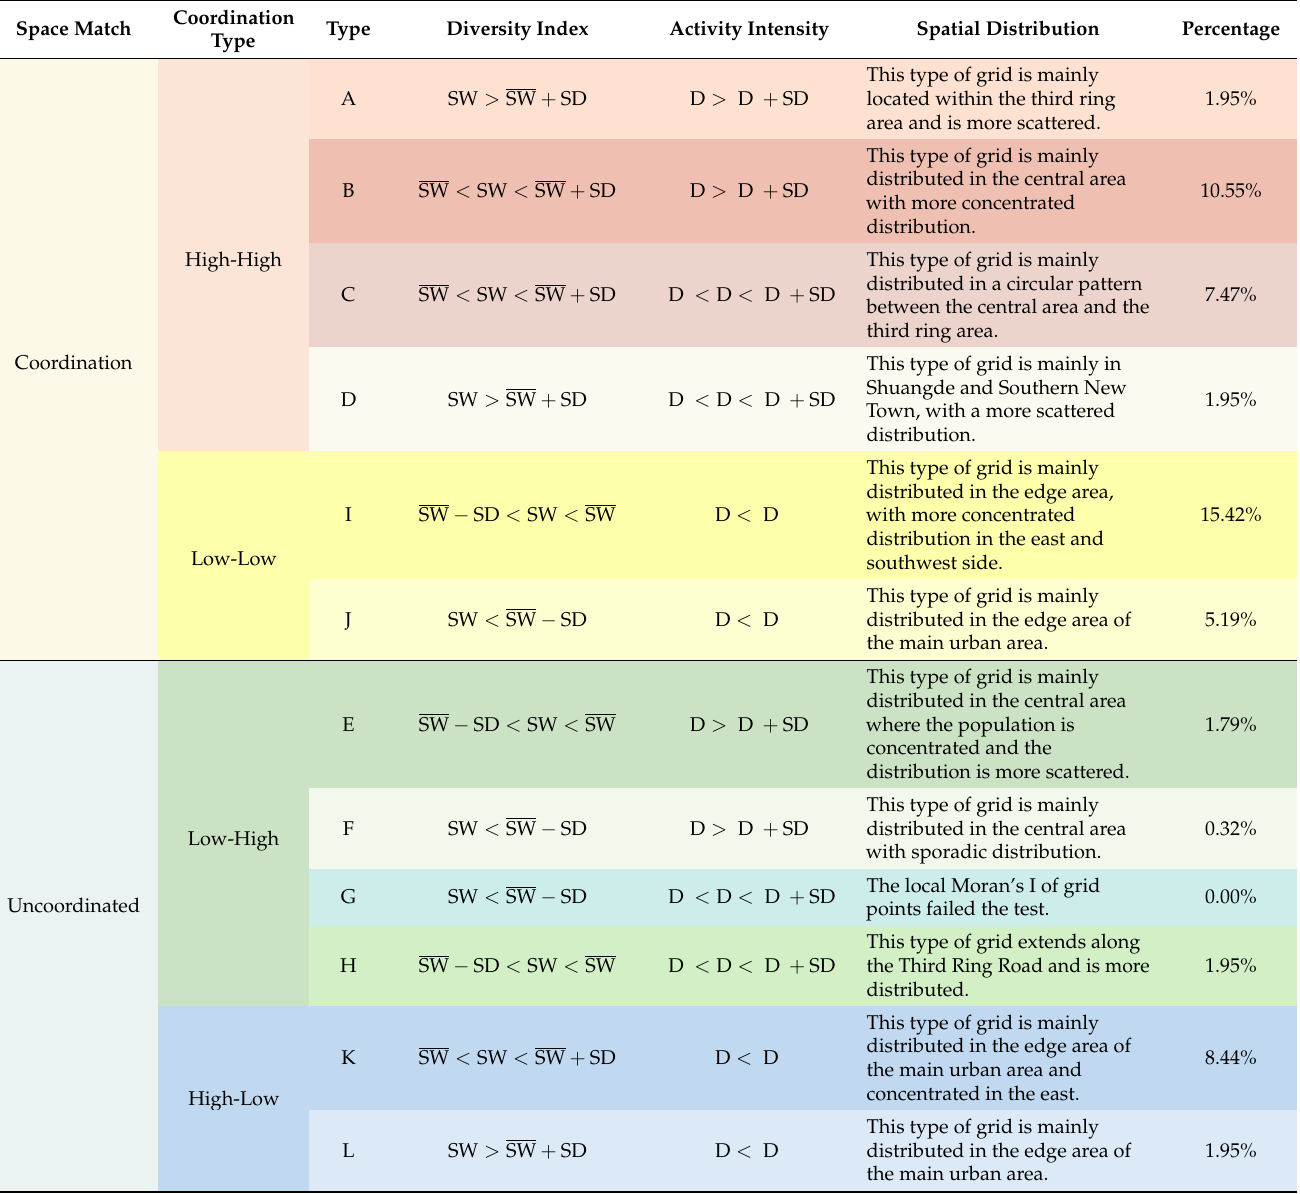
Table 2. Characteristics of the spatial match between service facility diversity and population activity